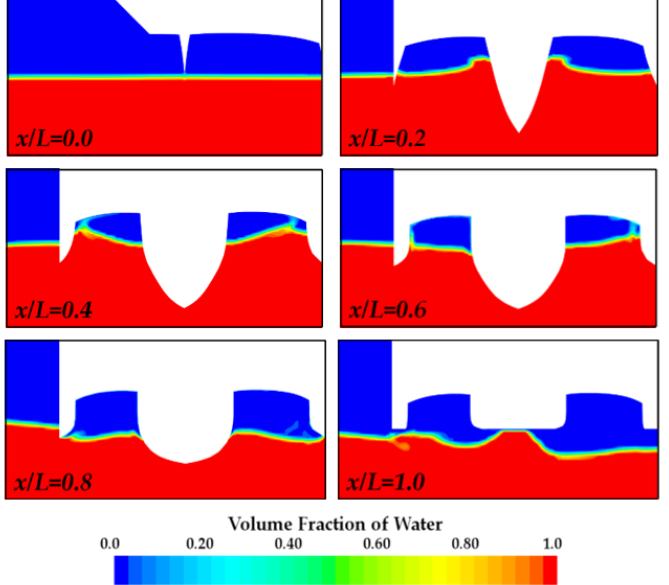
Figure 9. The air-water distribution through the tunnels of the Double-M craft at each YZ section (Fr = 0.7).